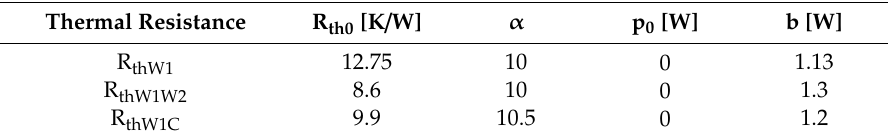
Table 1. Values of the parameters in Equation (2) for a toroidal transformer with a toroidal powdered iron core (RTP).